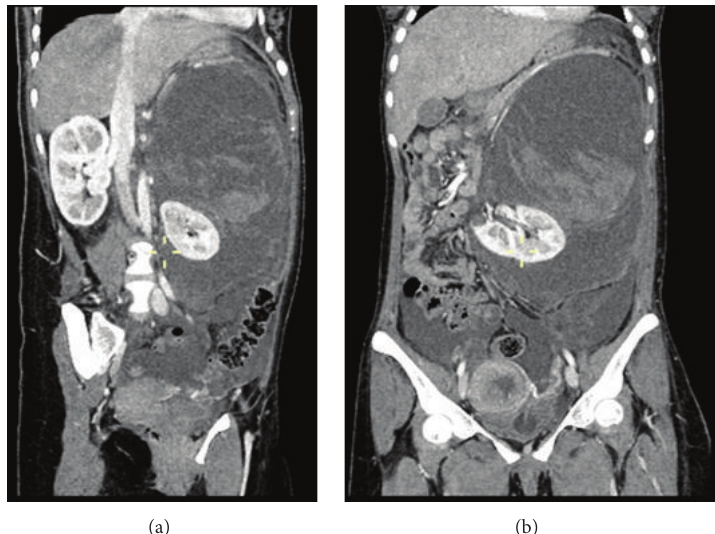
Figure 4: Coronal section showing massive haematoma and displaced left kidney. Cystic lesion in upper pole of left kidney is visible.